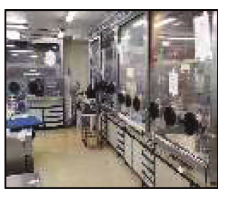
Fig. 4. Fume cupboards.